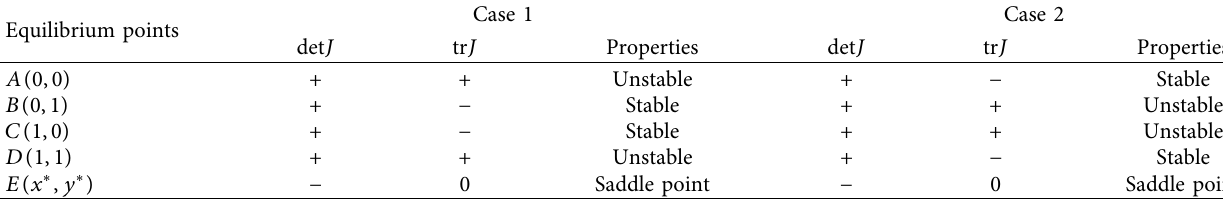
Table 4: Properties of the equilibrium points in Cases 1 and